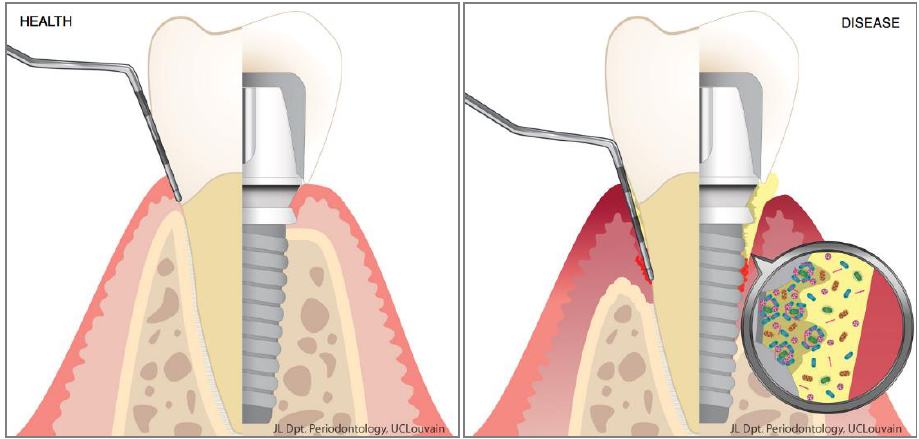
Figure 1. Periodontal/peri-implant tissues in health and disease. In the diseased state, the dysbiotic oral biofilm (yellow) that accumulates on the tooth/implant surface is responsible for the destruction of the supporting tissues through unresolved inflammation. This leads to the formation of periodontal/peri-implant pockets.